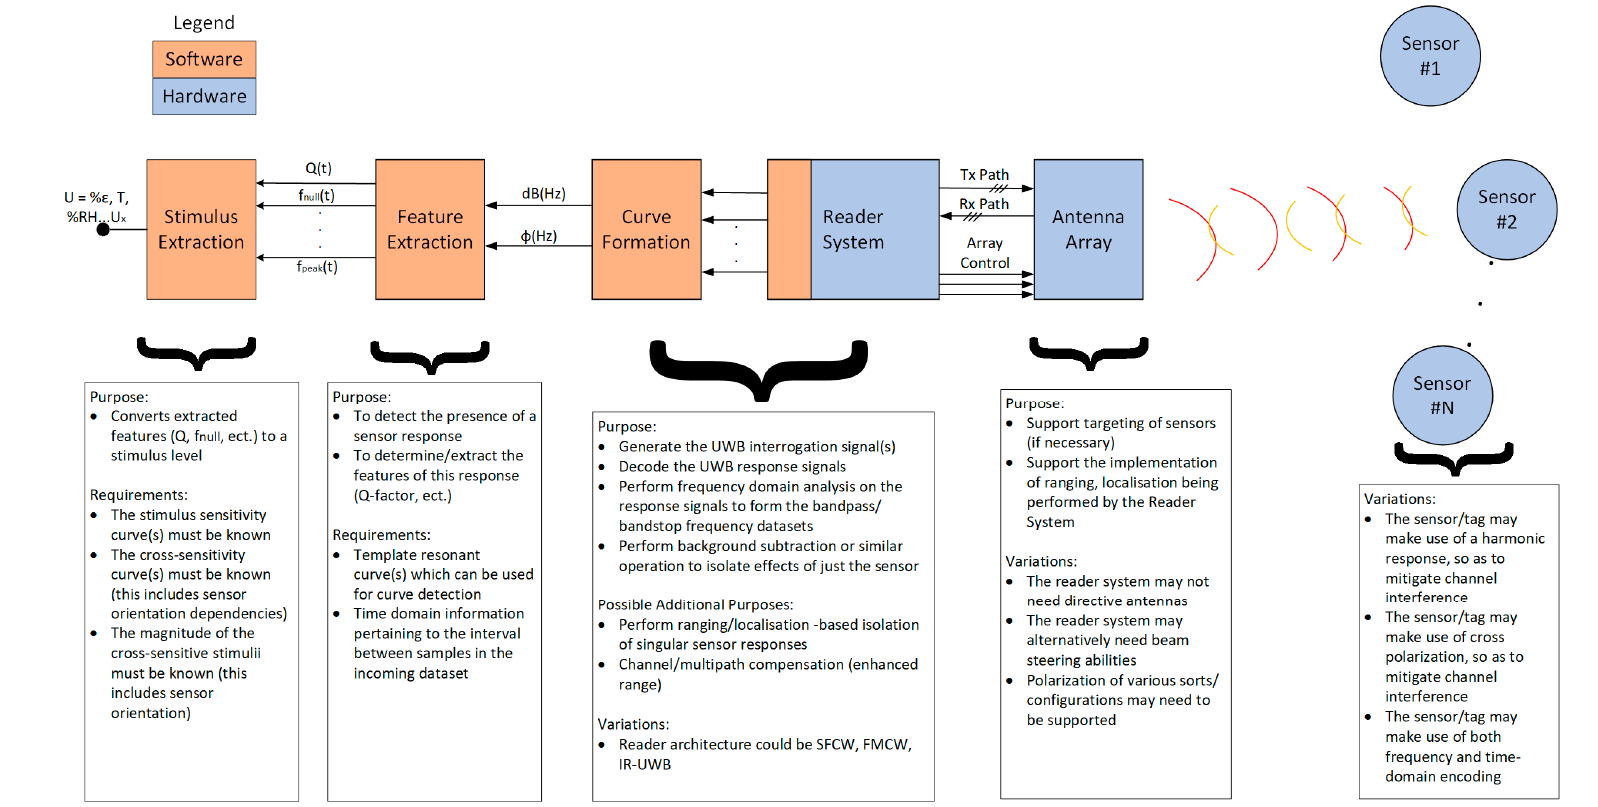
Figure 1. Interrogation system block diagram.